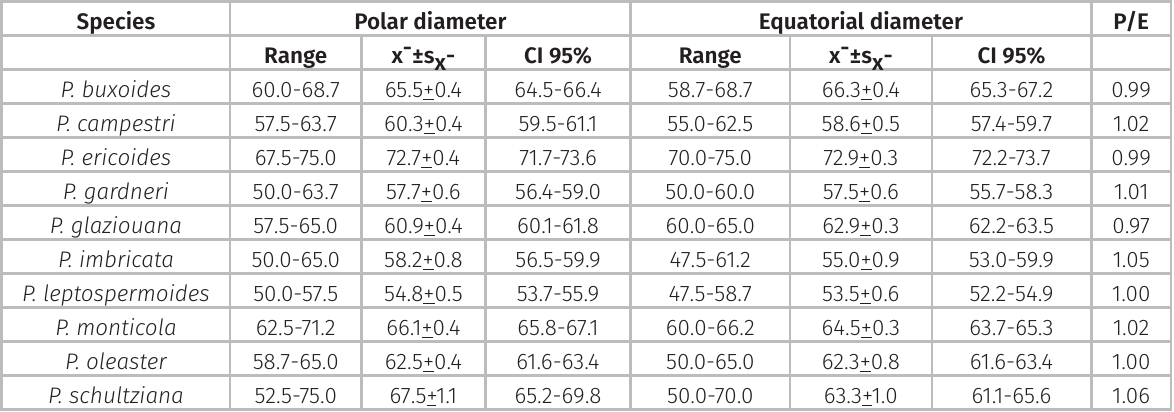
Table I. Measurements (in µm) of pollen grains in equatorial view of Piptolepis species. x- - arithmetic mean; sx- - standard deviation; CI - confidence interval; P/E - relationship between the polar and equatorial diameters.